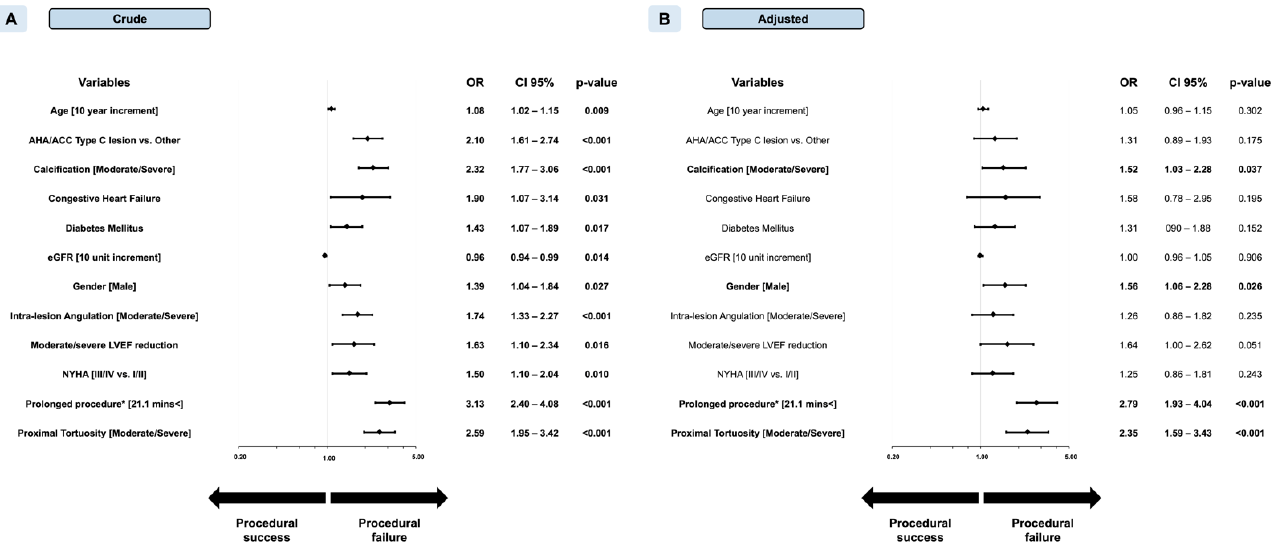
Figure 2. Forest plot of crude (Panel A ) and adjusted (Panel B ) odds ratios (OR) for prediction of procedural success in nonocclusive percutaneous coronary intervention (non-CTO PCI). ACC, American College of Cardiology; AHA, American Heart Association; CABG, coronary artery bypass graft; eGFR, estimated glomerular filtration rate; LVEF, left ventricular ejection fraction; MI, myocardial infarction; NYHA, New York Heart Association. * Indicates fluoroscopy time (min). Left ventricular function groups are indicated as follows: normal (52–100%) moderately reduced (41–51%), reduced (30–40%), and low (0–29%) in males; and normal (54–100%), moderately reduced (41–53%), reduced (30–40%), and severely reduced (0–29%) in females.